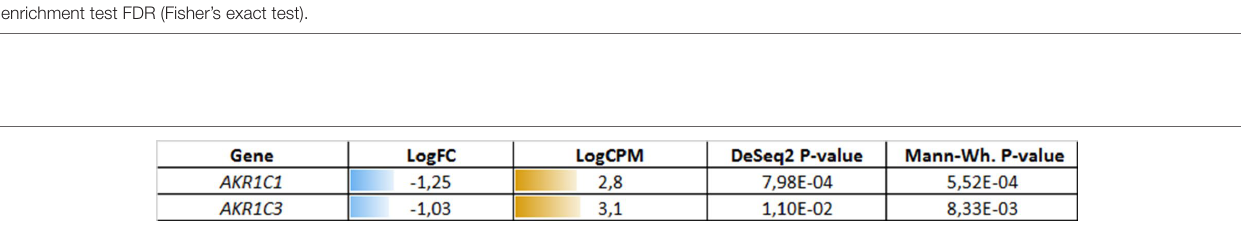
FIGURE 9 | Potential markers of unfavorable prognosis in lymph node-negative LAPC involved in the enriched KEGG pathways (Russian patient cohort). LogFC—trimmed binary logarithm of average expression-level fold change (between the groups of favorable and unfavorable prognosis); LogCPM—binary logarithm of read counts per million